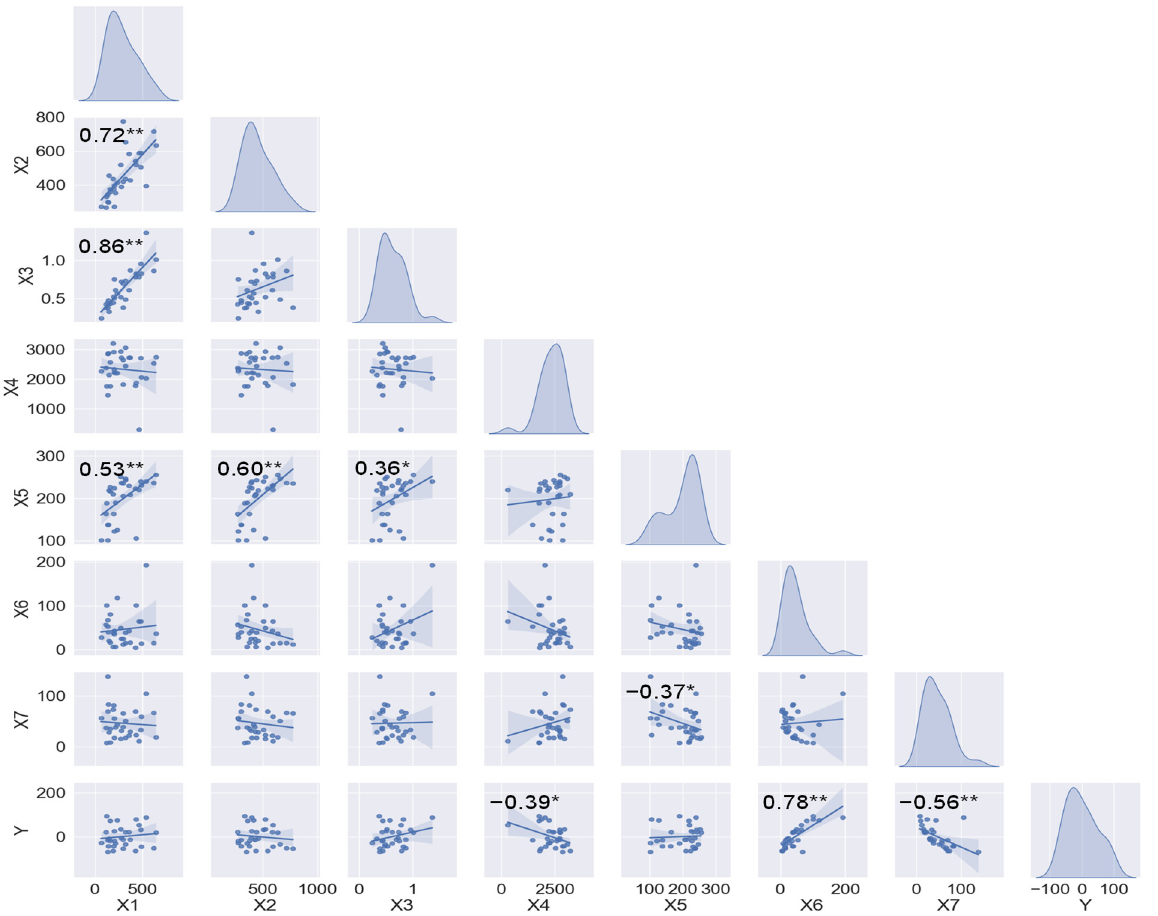
Figure 10. The curves are the multivariate joint distribution map and the scatterplots with a linear-fitted line show the linear correlation between any two variables of Tongtian River hydrology, sediment, and channel changes. X1 is the average annual sediment-transport rate (kg/s). X2 is the average annual streamflow (m 3 /S). X3 is the average annual sediment content (kg/m 3 ). X4 is the water-body area (km 2 ). X5 is the unchanged area of the river (km 2 ). X6 is the accretion area (km 2 ). X7 is the erosion area (km 2 ). Y is the overall accretion–erosion area (km 2 ). The symbols “**” and “*” indicate that the correlation coefficient has passed the significance test at the level of 0.99 and 0.95 respectively. Those scatterplots without marking correlation coefficients indicate an insignificant correlation.